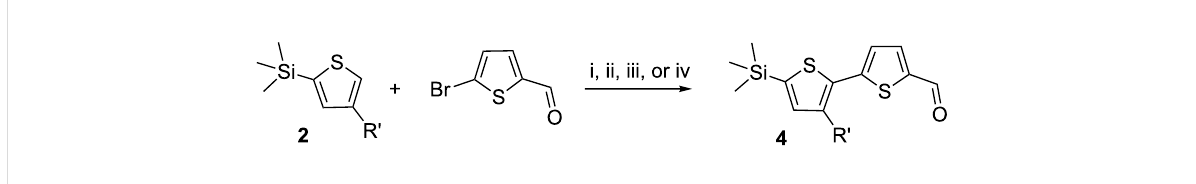
Scheme 3: Synthesis of the bithiophene through palladium catalyzed direct arylation, a) i) Pd(OAc) 2 , PCy 3 , PivOH, K 2 CO 3 , toluene 100 °C, 4 h, 1%, ii) Pd(OAc)